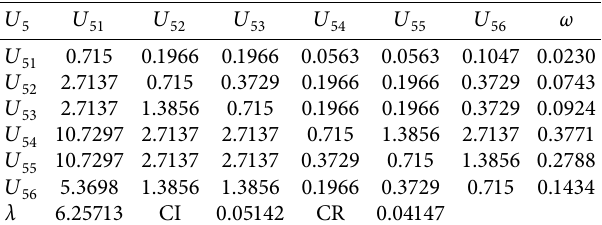
Table 9: Indicator judgement matrix and the weights of the ecological